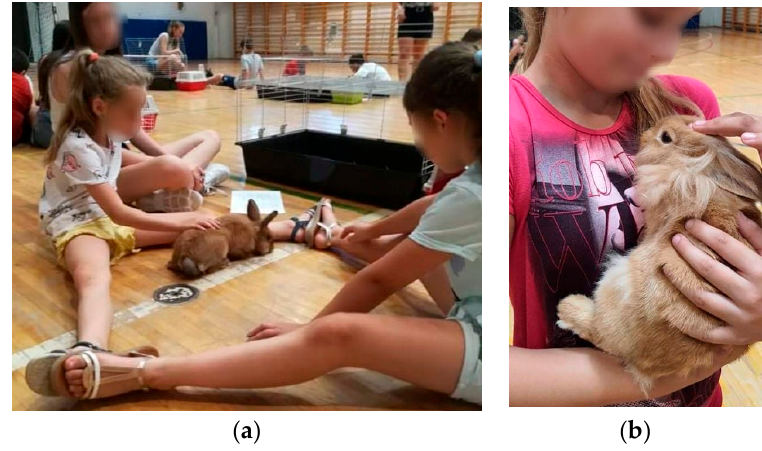
Figure 2. CAT ( a ) rabbits on the floor and ( b ) rabbits in children’s hands .